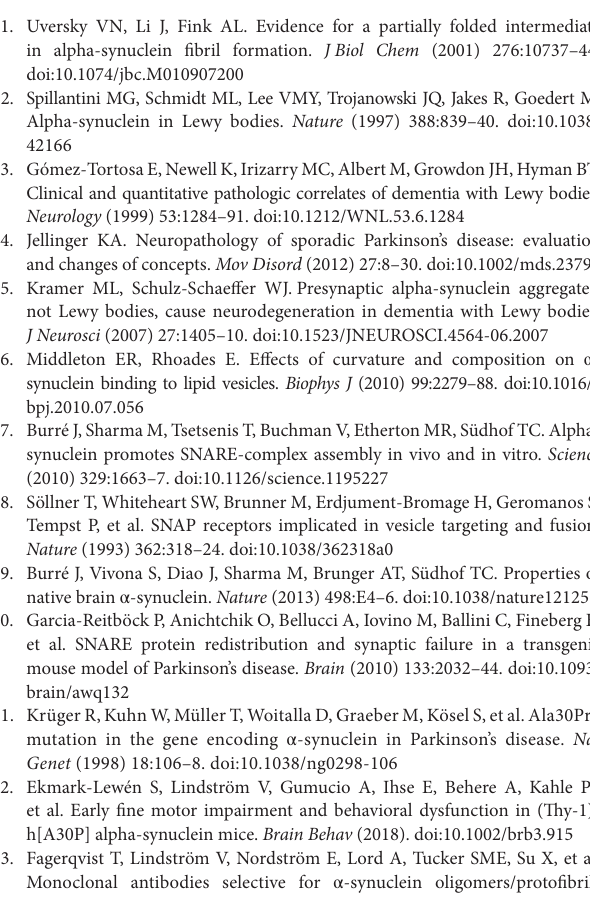
FigUre s1 | In situ PLA (red) between alpha-synuclein ( α Syn) and VAMP-2 (a) , α Syn and SNAP-25 (B) , and α Syn and syntaxin-1 (c) . Sample maximum intensity projections of unprocessed images, which were used for quantification of in situ proximity ligation assay (PLA) between α Syn and SNAREs in non-tg and A30P cortical primary neurons [ (a–c ), upper panel]. The lower panels (a–c) display the red channel of the same images after deconvolution, and set to the same threshold as was used for the quantification. All PLA puncta from each plane were quantified with ImageJ 3D Objects Counter on deconvolved and thresholded z-stacks. DAPI in blue. Scale bar 20